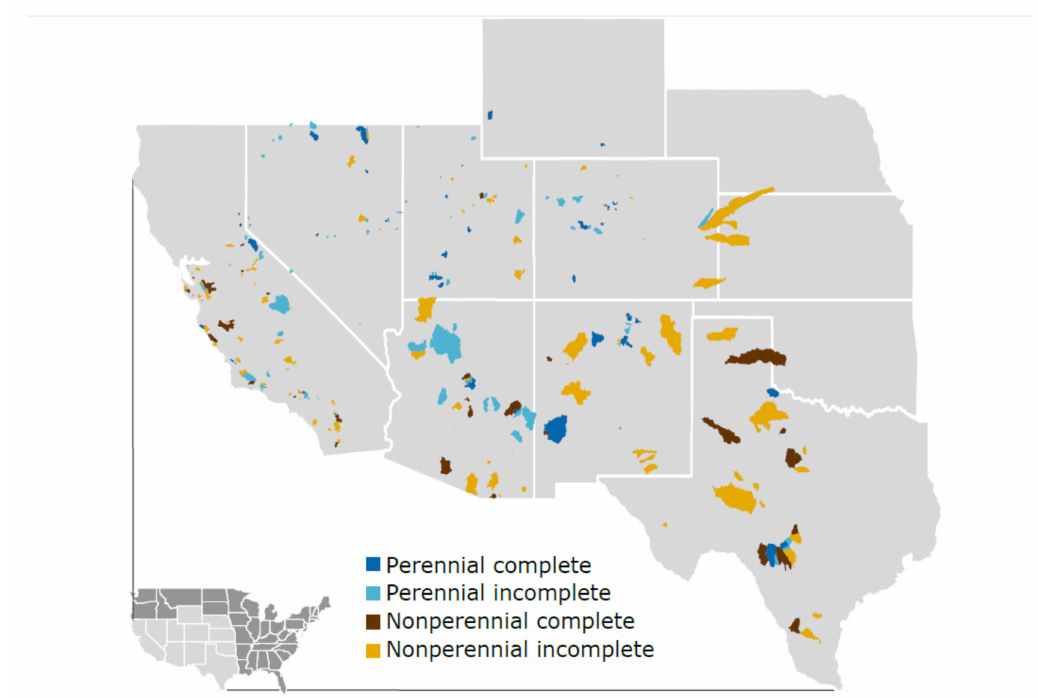
Figure 2. Map of the 287 basins with complete (dark blue, dark brown) and partial (light blue, light brown) USGS GAGES II reference streamflow data. Nonperennial reaches are in brown and perennial reaches are in